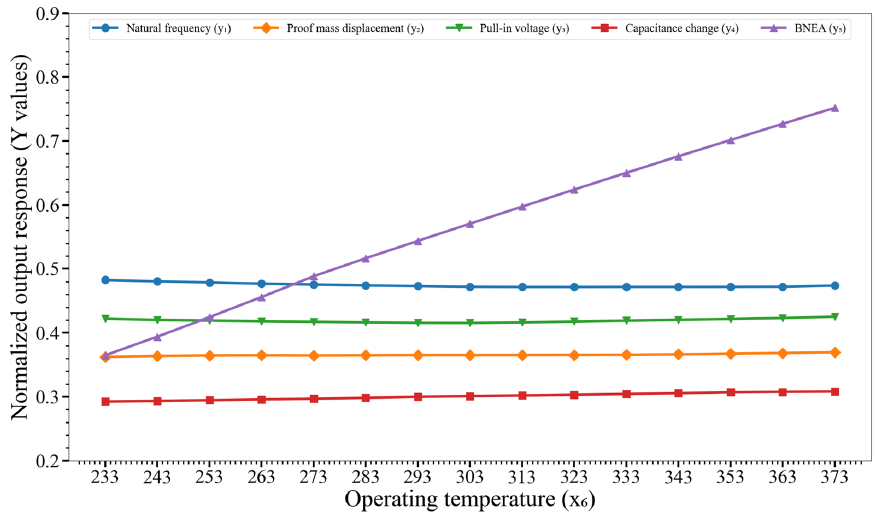
Figure 12. E ff ect of variation of the operating temperature (x 6 ) on the output responses y 1 , y 2 , …, y 5 . Figure 12. Effect of variation of the operating temperature (x